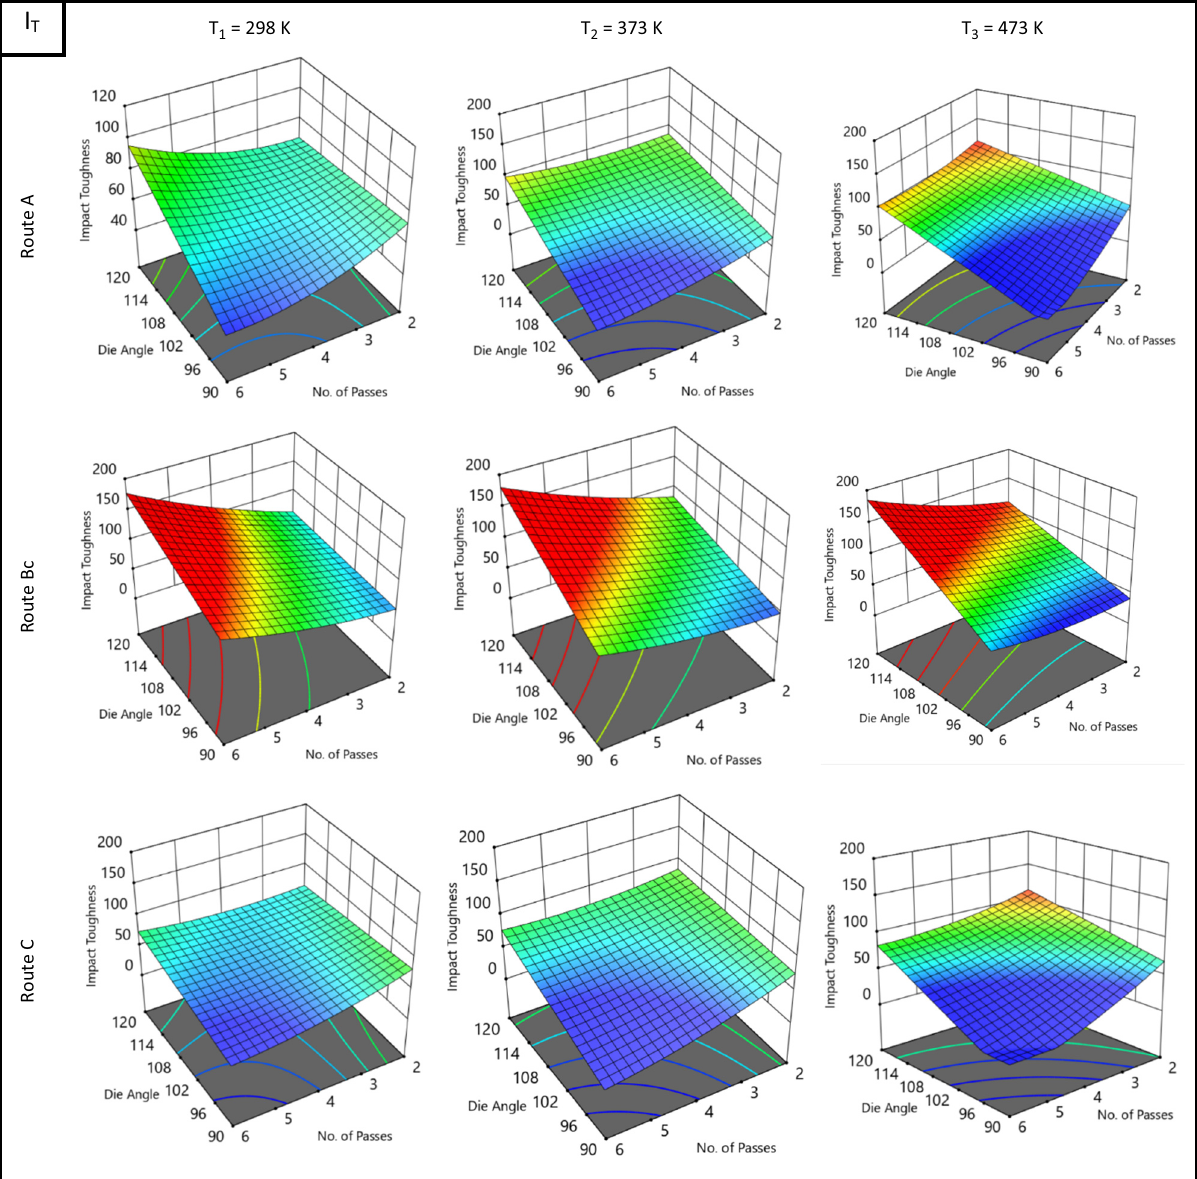
Figure 17: Response surface plot of I T as a function of die angle, number of passes, route type, and processing